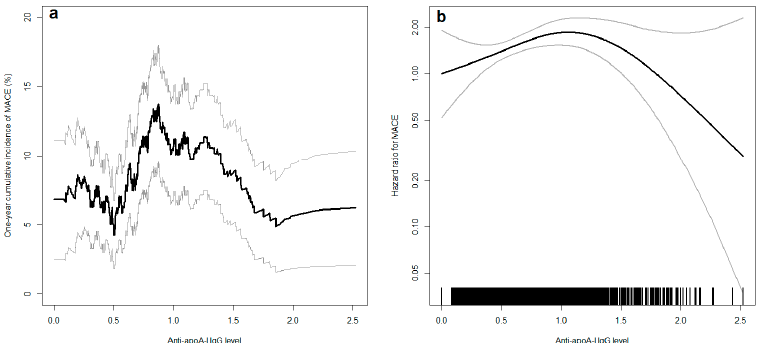
Figure 2. ( a ) Cumulative incidence of major adverse cardiovascular events (MACE) at one year according to autoantibodies against apolipoprotein A-I (anti-apoA-I IgG) levels (in optical density (OD)) in univariate analyses (black line). ( b ) Hazard ratio for MACE according to anti-apoA-I IgG levels (black line) adjusted for the categories of the Global Registry of Acute Coronary Events (GRACE) score 2.0. The vertical black lines above the x-axis represent the distribution of anti-apoA-I IgG levels in the study population: each vertical line represents the value of one participant. In both panels, the grey lines represent the 95% confidence interval. The distribution of anti-apoA-I IgG values was as followed: from 0 to 0.5 OD: n = 544 (31.8%); >0.5 and ≤ 1.0: n = 774 (45.2%); >1.0 and ≤ 1.5: n = 292 (17.0%); >1.5 and ≤ 2.0: n = 89 (5.2%); >2.0: n = 14 (0.8%).